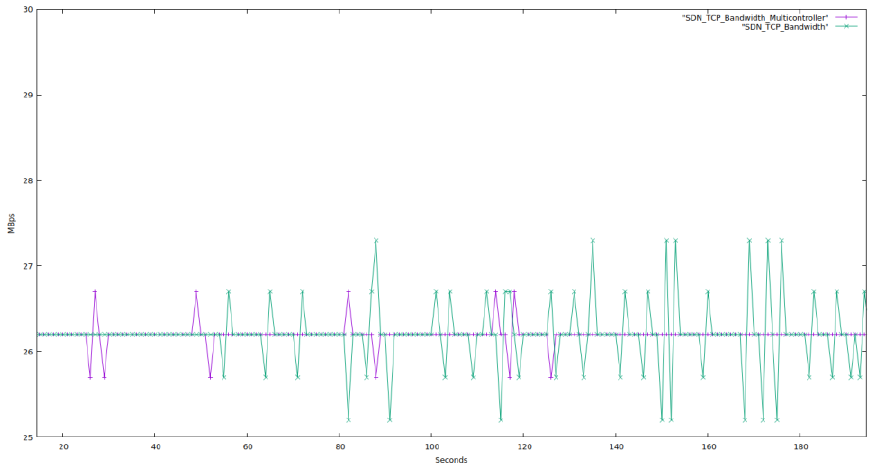
Figure 12. Bandwidth Fluctuation TCP single-controller SDN vs. TCP Multi-controller SDN.